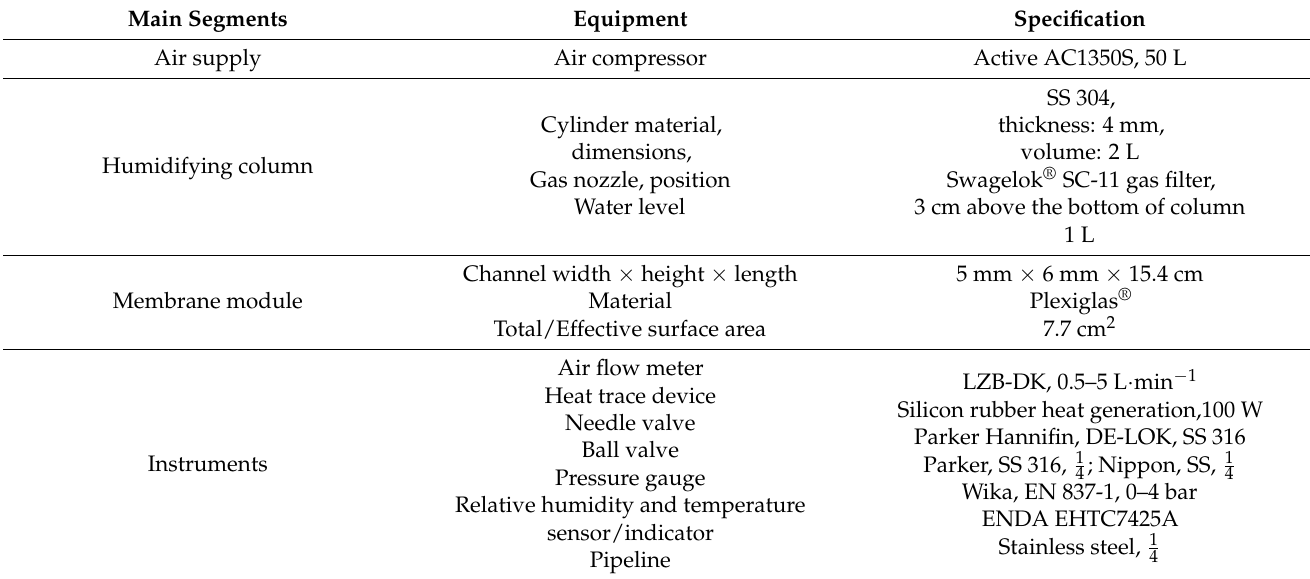
Table 1. The main components of membrane-based heat exchanger setup with detailed specification.